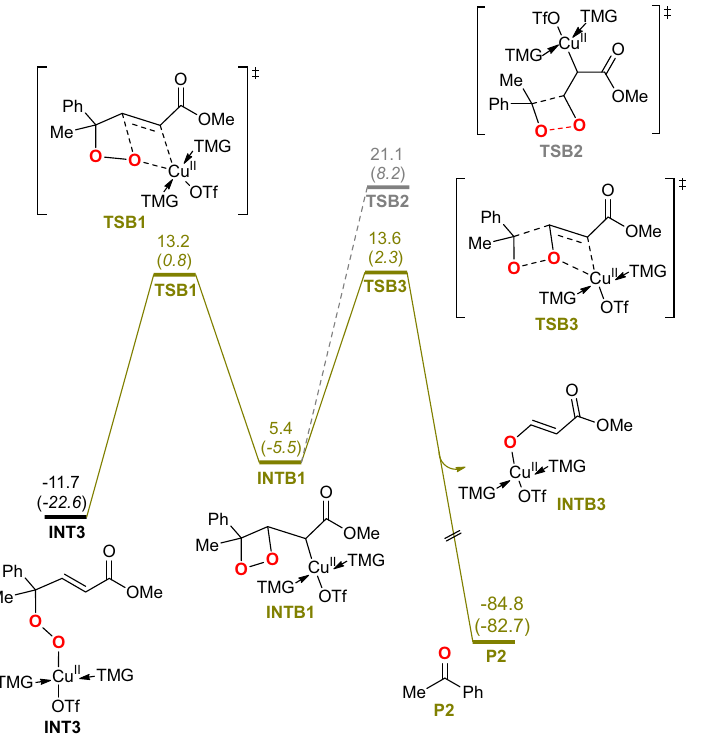
Figure 5. The possible formation routes of acetophenone byproduct. Relative free energies (electronic energies) are in